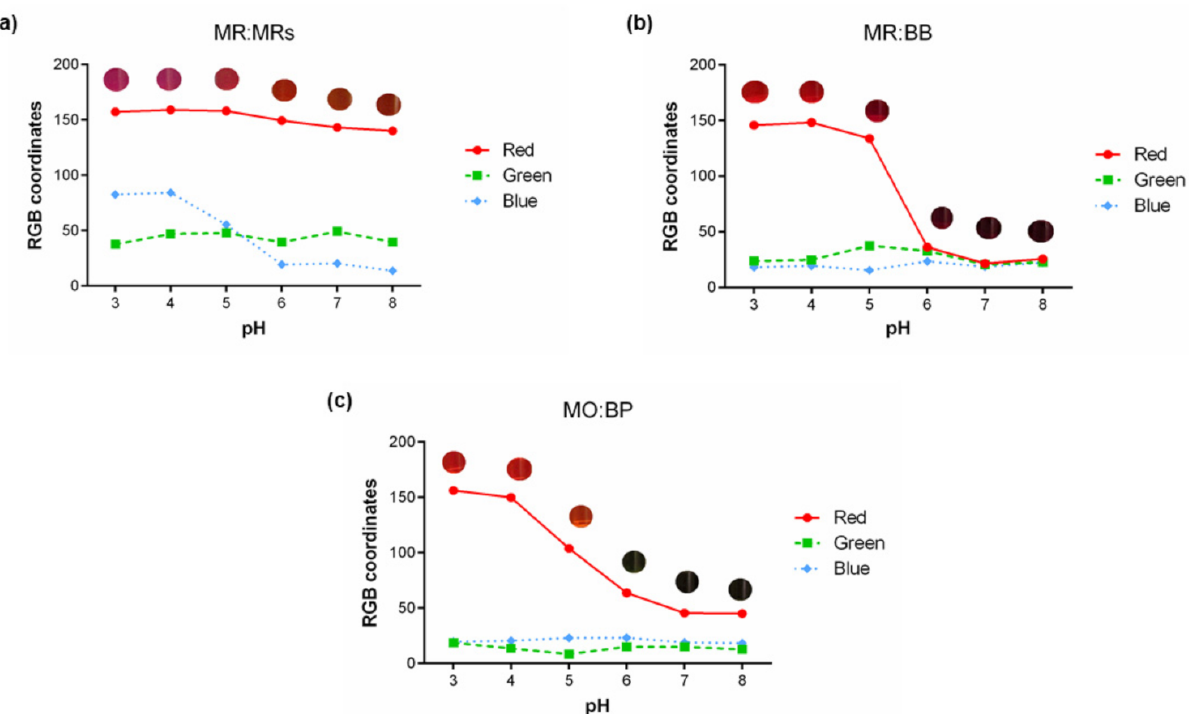
Figure 3. Graphical correlation of the aqueous solution color changes in response to pH. Results obtained for ( a ) MR:MRs 0.5% ( w / v ), ( b ) MR:BB 0.5% ( w / v ), and ( c ) MO:BP 0.5% ( w / v ) are expressed in RGB coordinates and the color obtained for every pH value is